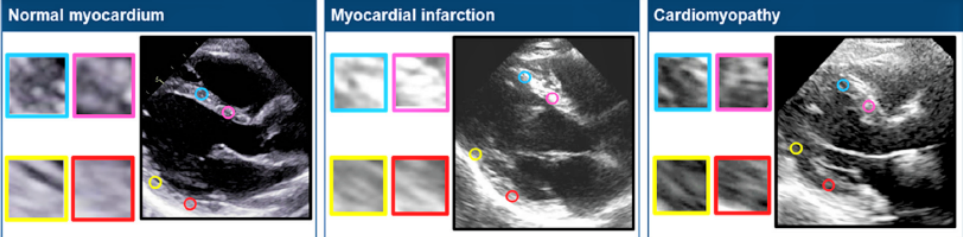
Figure 6. Prognosis of myocardial fibrosis. Three ultrasound renderings and the corresponding myocardial textures